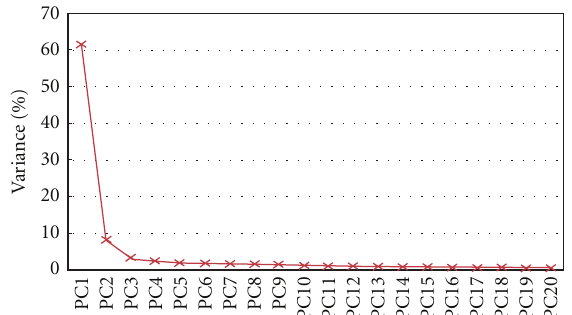
Figure 3: Principal components’ scree plot. Only the first 20 PCs of the resulting 70 PCs are shown.